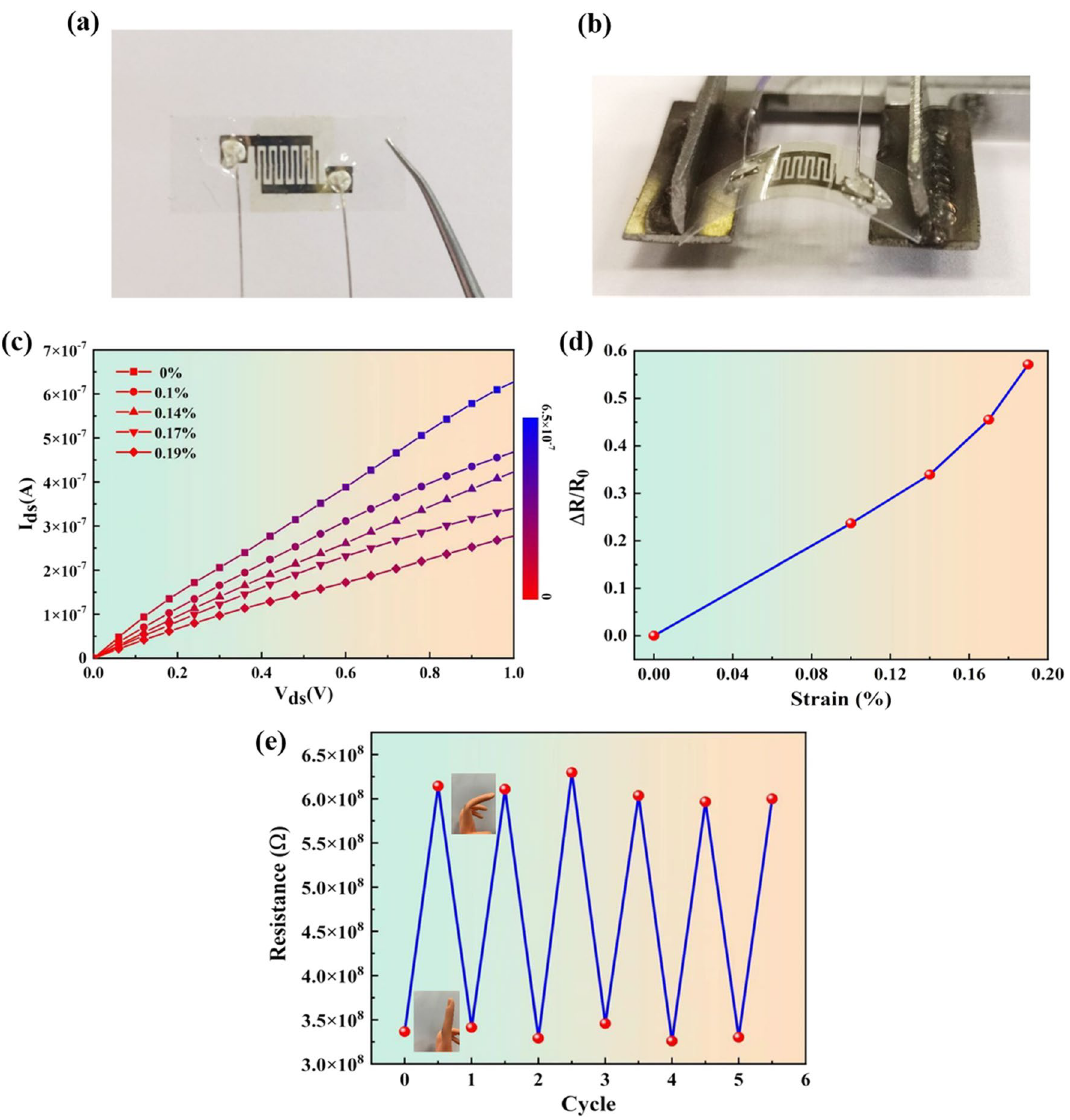
Fig. 6 a – b Pictures of as-fabricated and bending WS strain sensor under different applied strain. d Change rate of resistance of WS 0.19%. The GF can be calculated as ~ 306. e The resistance change response to repeating prosthetic finger bending. Insets are the flexible WS /PEN sensor attached on the prosthetic finger to detect its bending 2